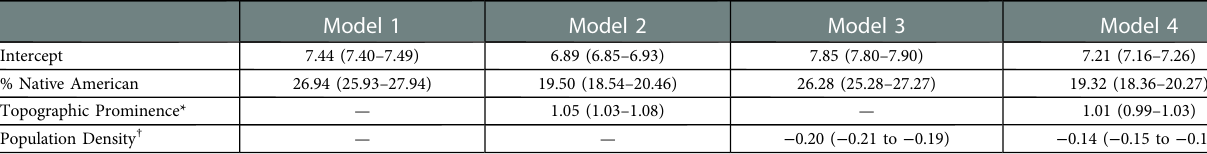
TABLE 5 Associations between census tract sociogeographic characteristics and distance to nearest GHCN station.